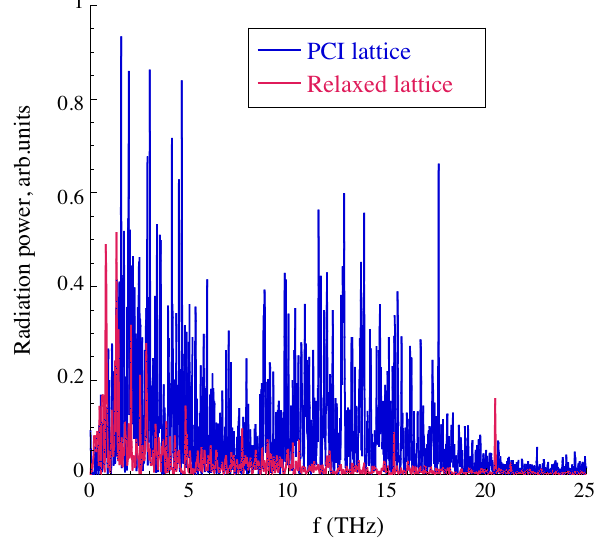
FIG. 18. Power spectra of the time distribution in the 1.5-nC electron bunch compressed to a peak current of 75 A and accelerated to 14.6 MeV in the CeC accelerator, simulated by the I mpact- T code. The blue line is for the beam propagating though a strong focusing PCI lattice, while the red line is for a beam propagating though the relaxed LEBT lattices. Strong focusing in the LEBT results in an increase of 1 – 2 orders of magnitude of the beam noise power at frequencies around 12.5